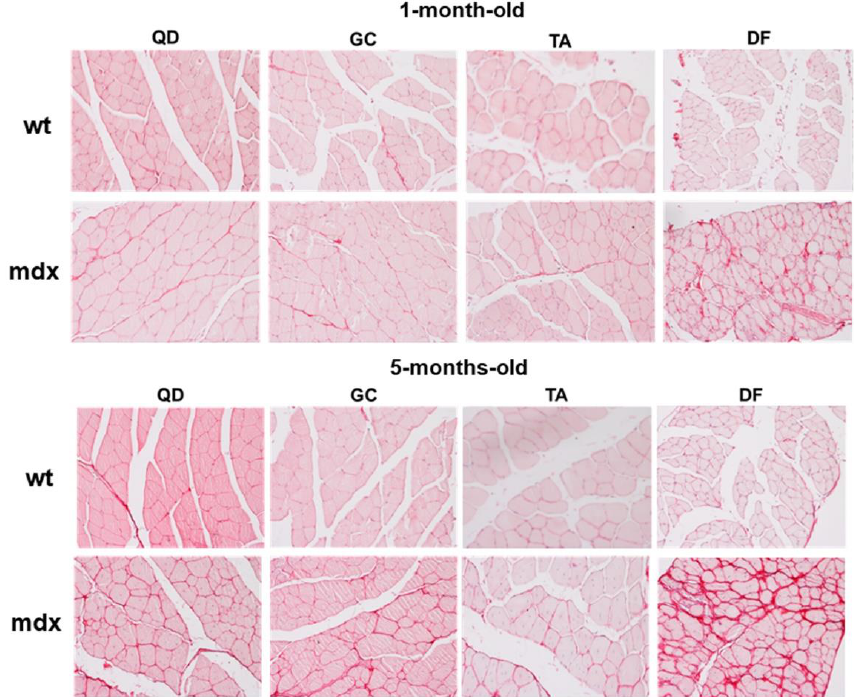
Figure 1. Representative Sirius red stained sections showing collagen content in quadriceps (QD), tibialis anterior (TA), gastrocnemius (GC), and diaphragm (DF) of young (1-month-old) and adult (5 months-old) mice. Original magnification: 20×.